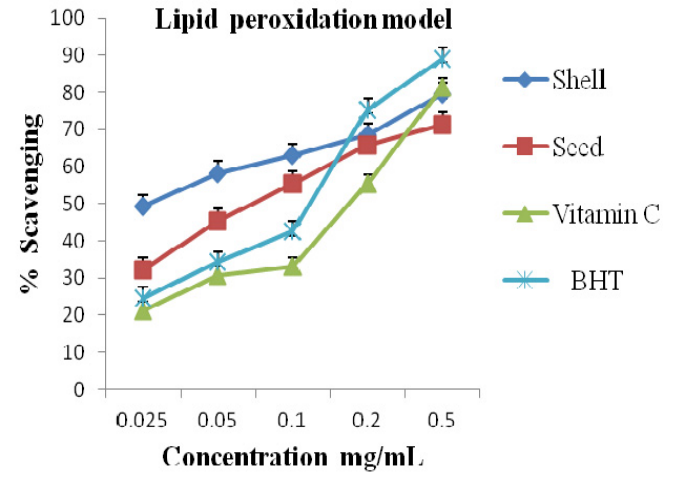
Figure 3. Antioxidant activity of the shell and seed essential oils extracted from A. precatorius on lipid peroxide radicals.